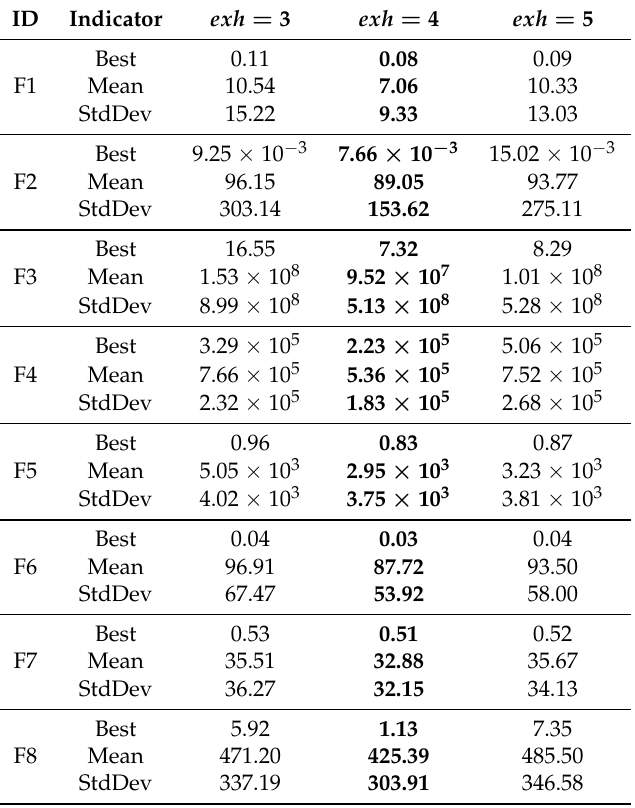
Table 5. Experiments with varying exh parameter value of the MBO-ABC for benchmarks with 30 dimensions (bold style is used to indicate better